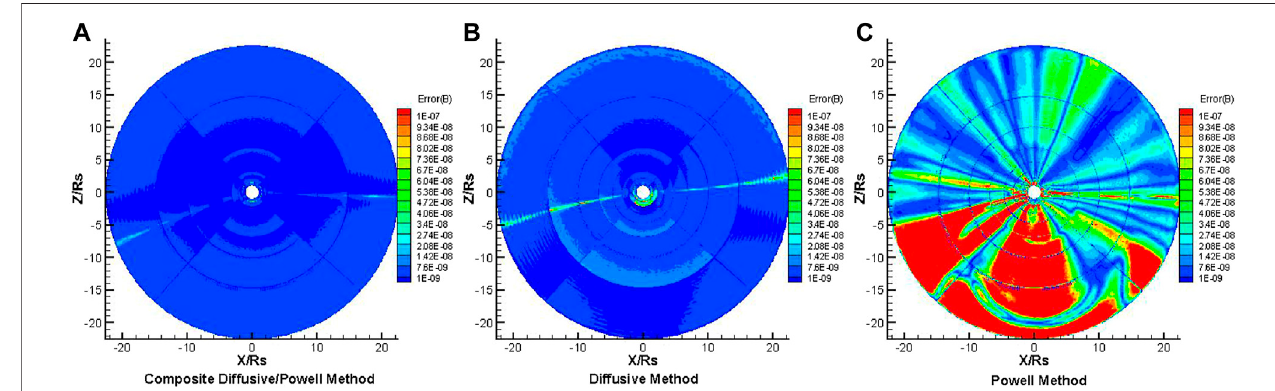
FIGURE6 | Thedistribution of Error ( B ) on the meridional plane of Φ (cid:2) 180 ° – 0 ° from 1 to22.5R S, from compositediffusive/Powell method (A) , diffusive method (B) , and Powell method (C) , respectively.